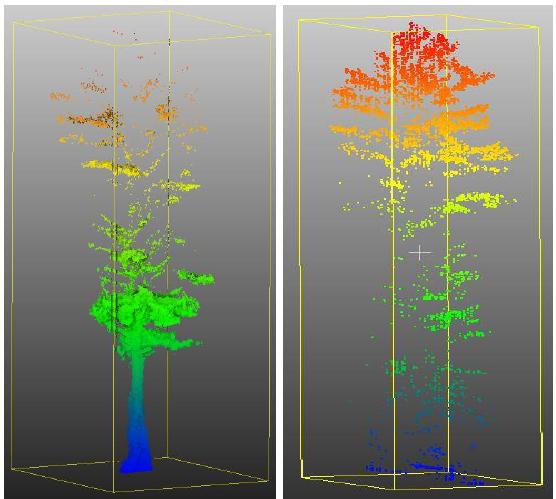
Figure 6. Visual and manual assessment using ZEB REVO GeoSLAM data captured below the canopy against extracted and measured tree from ULS data from above the